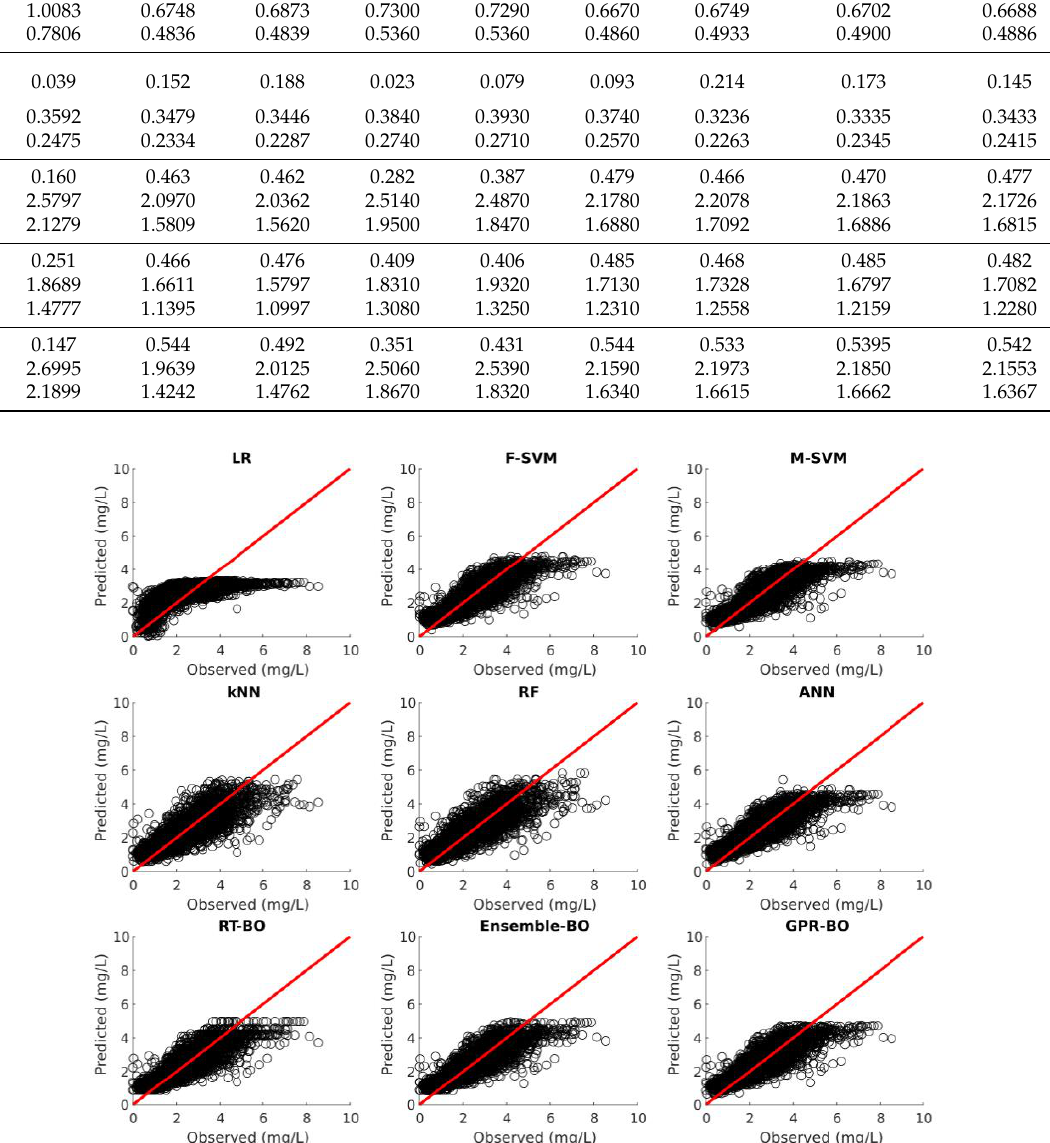
Figure 2. Observed versus predicted daily nitrate concentration for the Cuyahoga watershed using different ML algorithms.